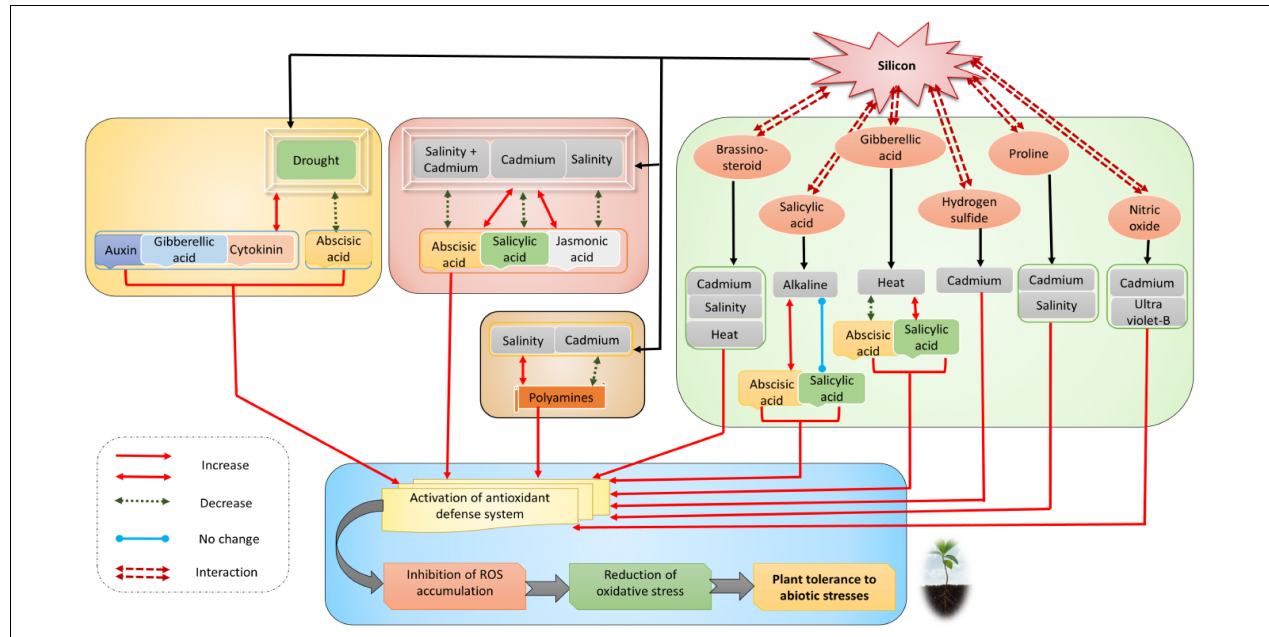
FIGURE 3 | Interaction and crosstalk network of silicon with phytohormones and other signaling molecules in response to various abiotic and oxidative stresses. Read the text for further information.